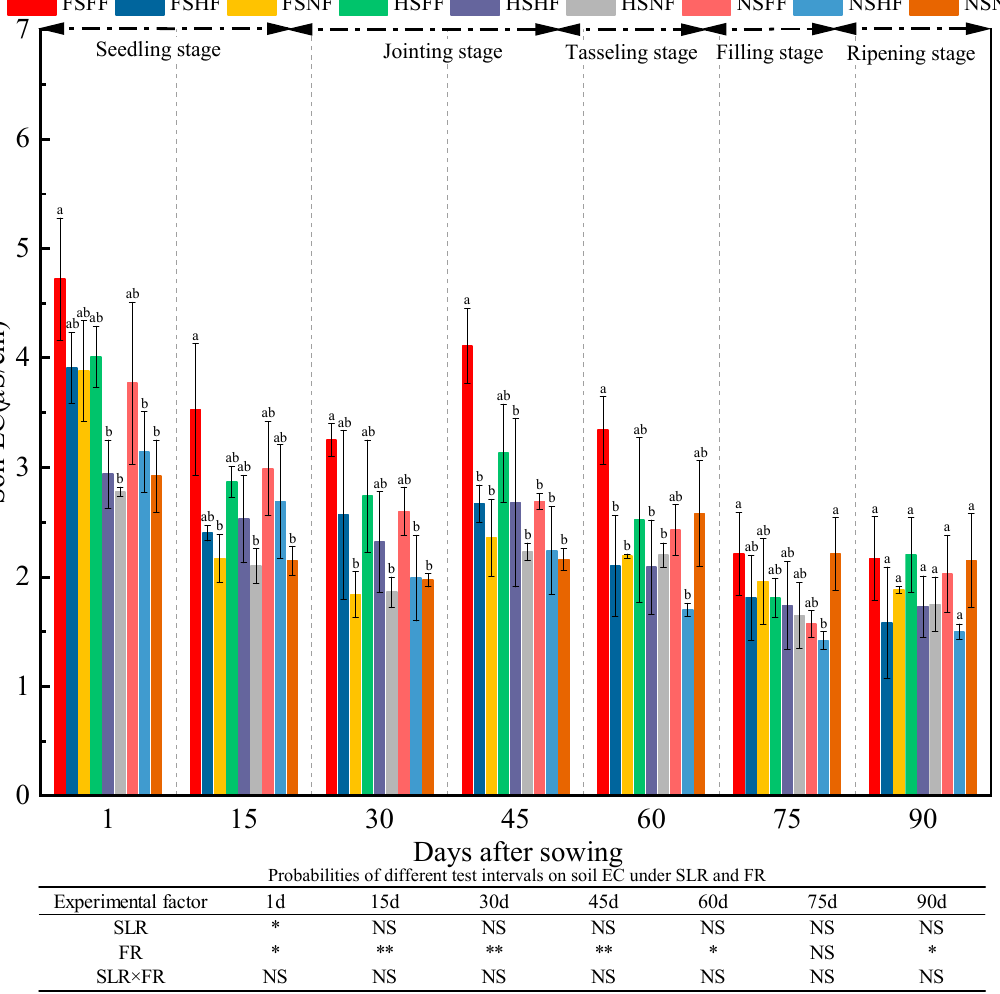
Figure 15. Effects of SLR and FR on soil EC. Note: Bars represent means ± standard deviation ( n = 3) with different letters indicating significant differences based on LSD ( p ≤ 0.05). SLR, sugarcane leaf return; FR, fertilizer reduction.